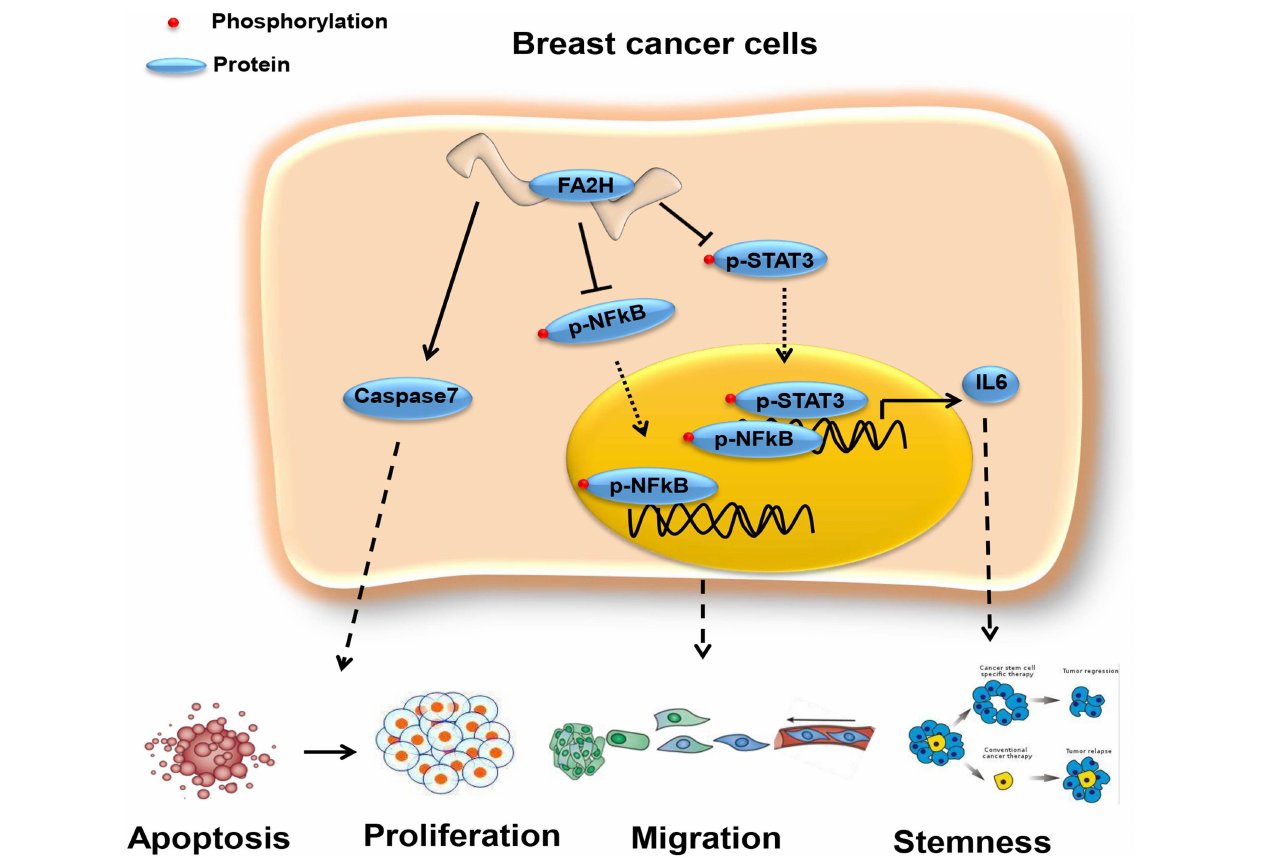
FIGURE 7 | Network revealing the tumor suppressive role of FA2H via the STAT3/IL6 axis and NFkB signaling. FA2H suppresses phosphorylation of NFkB and STAT3, reduces their nuclear transportation that ultimately leads to reduced expression of genes promoting cancer cell migration and stemness. FA2H induces Caspase 7, an executioner of apoptosis, and thus increased apoptosis and reduced proliferation.